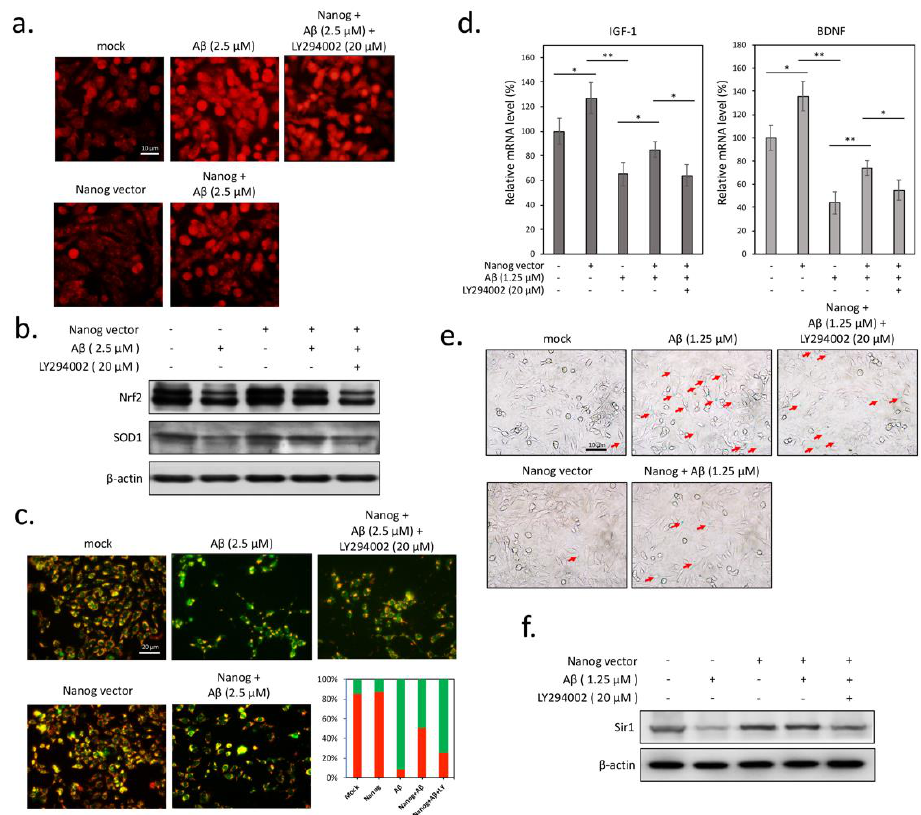
Figure 3. Nanog overexpression ameliorates Aβ -induced mitochondrial superoxide accumulation and cellular senescence. ( a ) Dihydroethidium (DHE) staining results showed that overexpression of Nanog reduces Aβ -induced intracellular superoxide accumulation; ( b ) levels of two antioxidant signaling-related proteins nuclear factor erythroid 2-related factor 2 (Nrf2) and superoxide dismutase 1 (SOD1) were analyzed by western blotting; ( c ) double fluorescence staining of mitochondrial membrane potential by JC-1 was used for detection of mitochondrial membrane potential. Green fluorescence indicated the decreased membrane potential in 2.5 μM of Aβ -treated SK-N-MC cells after 24 h. Red fluorescence indicated that overexpression of Nanog effectively preserves the mitochondrial membrane potential; ( d ) mRNA levels of neurotrophic factors insulin-like growth factor 1 (IGF-1) and brain-derived neurotrophic factor (BDNF) were measured by performing qPCR. mRNA levels of IGF-1 and BDNF were significantly increased in Aβ treated Nanog -overexpressed cells; ( e ) representative results of cytochemical detection of SA- β -galactosidase, a common biomarker used in detecting senescent cells. Senescent cells (red arrows) are blue stained under a bright-field microscope; ( f ) levels of sirtuin-1 (Sirt1) protein in Aβ -treated cells using western blotting. Values were expressed as means ± SEM from at least three independent experiments. The significance of differences was determined through multiple comparisons with Dunnett’s post hoc test at * p < 0.05 and ** p < 0.01 compared with the indicated groups. LY294002, a PI3K inhibitor for reducing insulin signaling.